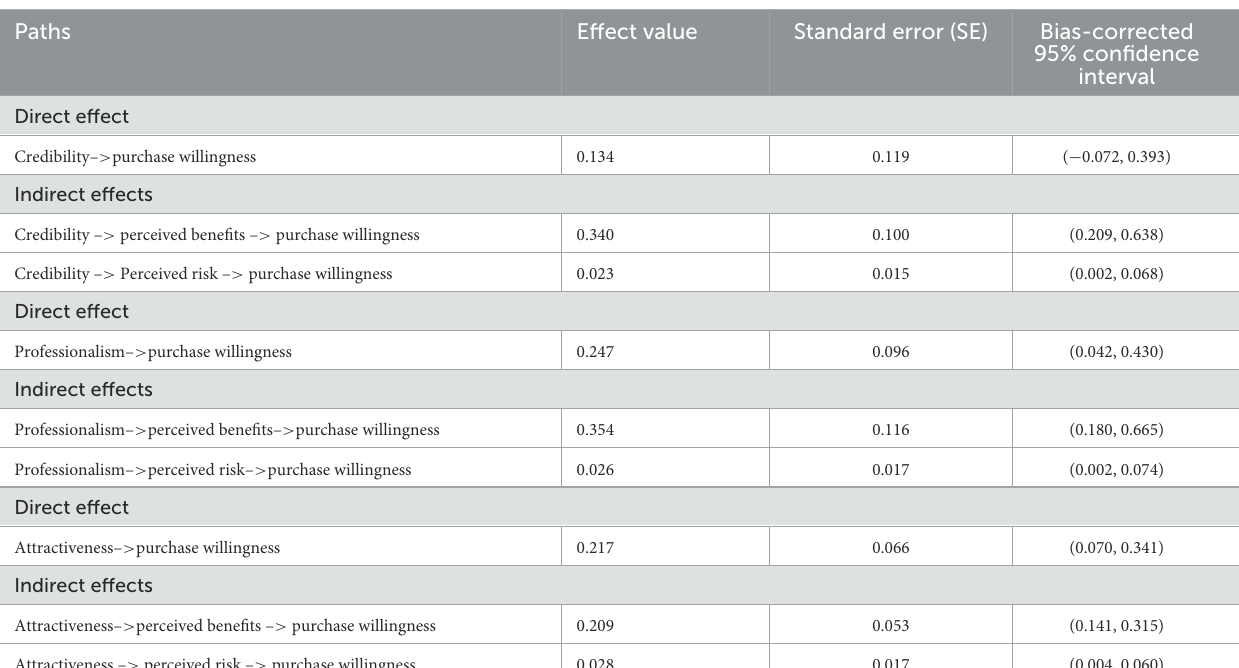
TABLE 6 Bootstrap estimation results of mediating